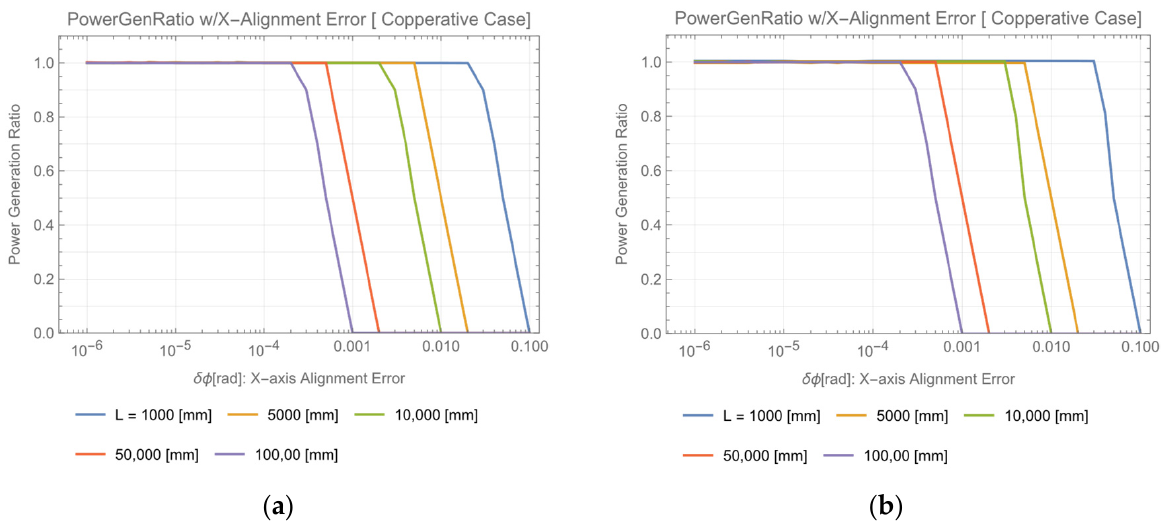
Figure 11. Power Generation Ratio Dependence on X(Y) Direction Deviation: ( a ) Focus Optimized at Each L; ( b ) Focus Optimized at 100 m.